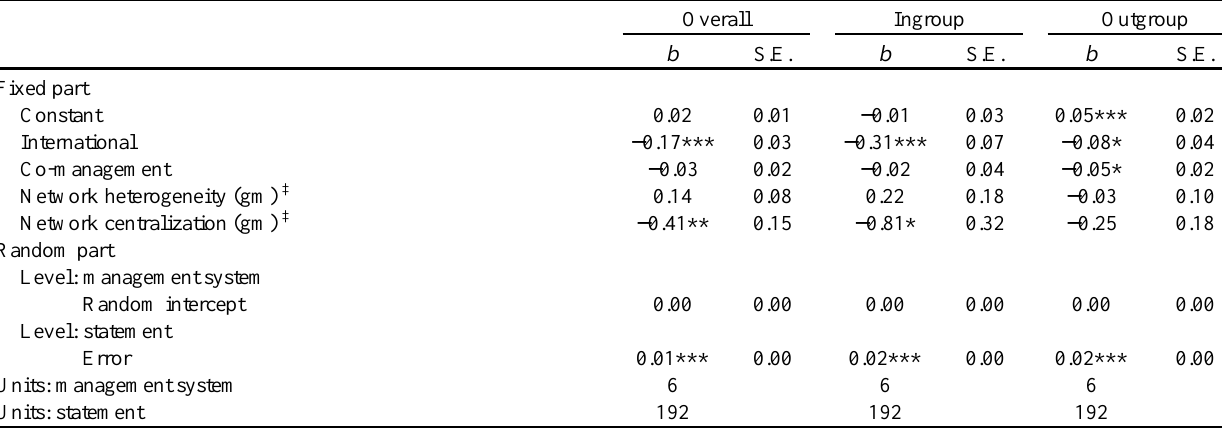
Table 4 . Multilevel regression results: unstandardized estimates and standard errors (Model 2). †